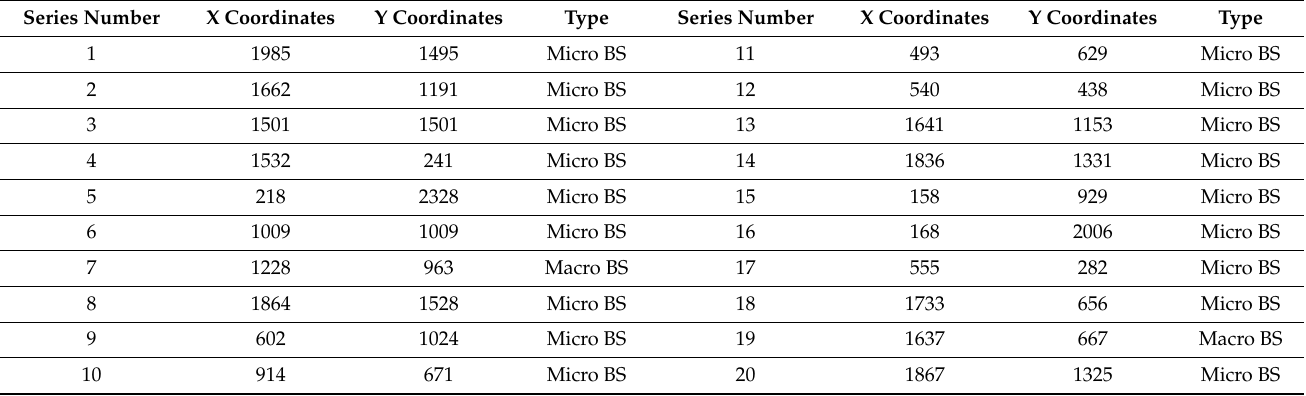
Table 2. Part results of the location coordinates and types of base stations needed to be established.